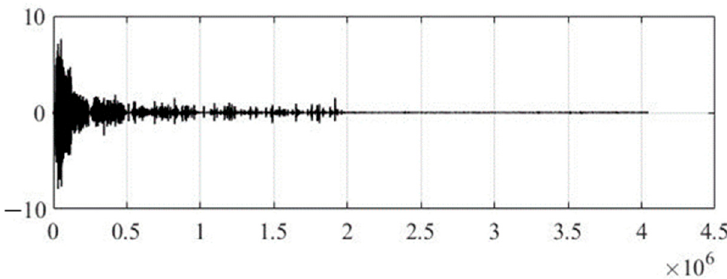
Figure 5. Wavelet coefficients of the original audio signal.